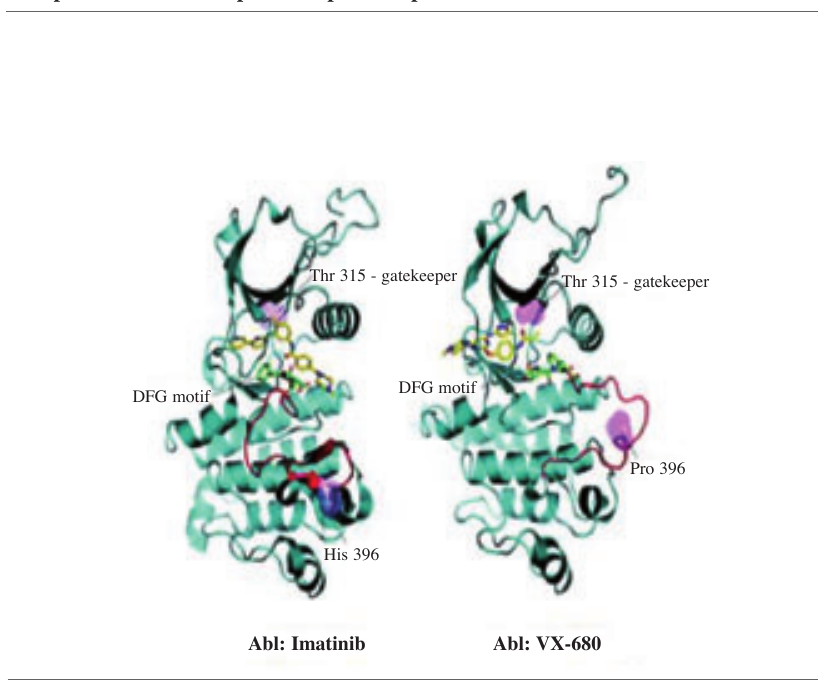
Figure 2. Chemical structure of VX-680 aurora kinase inhibitor. [Reprinted and adapted with permission from http://kinasepro.wordpress.com].